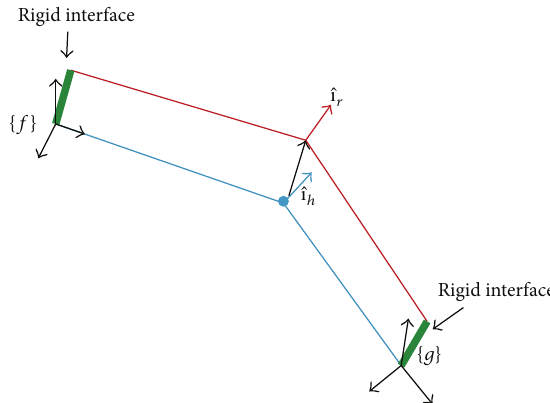
Figure 2: Representation of the simplified close kinematic chain formed by the exoskeleton (human in blue, robotic in